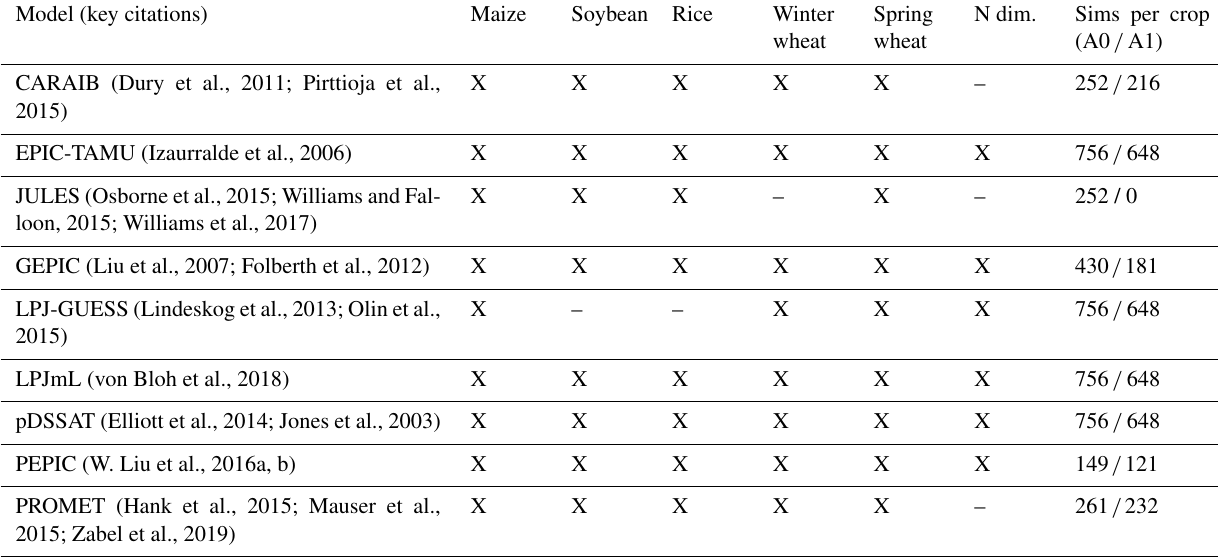
Table 1. Crop models included in GGCMI Phase 2 emulators and the number of CTWN-A (carbon dioxide, temperature, water, nitrogen, adaptation) simulations performed for each model. The maximum number is 756 for A0 (no adaptation) experiments, and 648 for A1 (maintaining growing-season length) experiments since T0 is not simulated under A1. “N dim.” indicates whether the models are able to represent varying nitrogen levels. Each model provides the same set of CTWN simulations across all its modeled crops, but some models omit individual crops. Table adapted from Franke et al. (2020a). For clarity, three simulation models that submitted data to the GGCMI Phase 2 experiment (Franke et al., 2020a) are not shown here, as they provided a training set too small to be used in emulation.